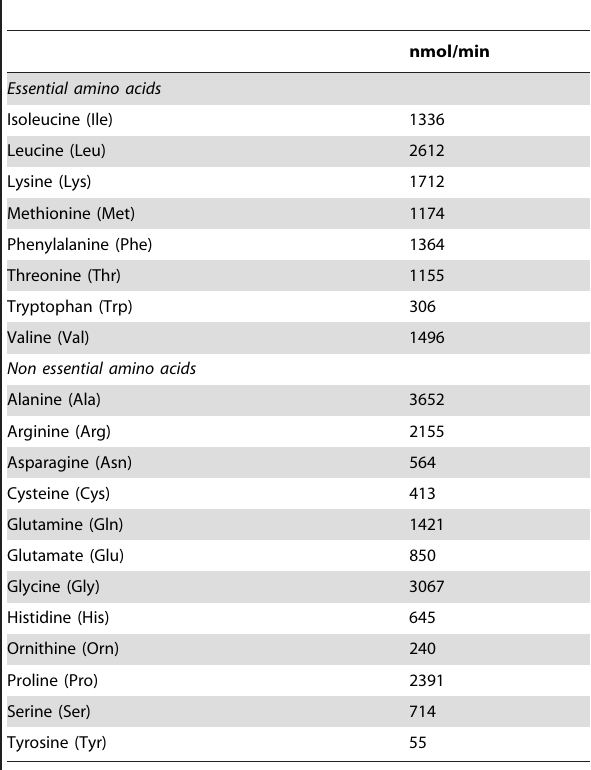
Table 1. Amino acid composition of the mixture infused into the rat duodenum.